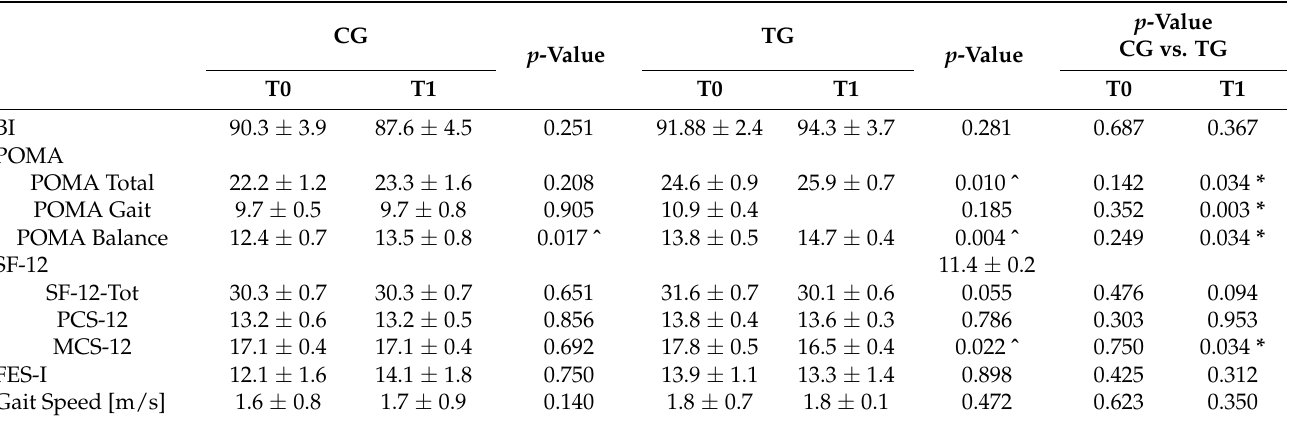
Table 2. Mean ± standard error of the mean of pre- and post-intervention scores on the BI, POMA (total, gait and balance), SF-12 (total, physical and mental component score), FES-I and gait speed. Pre-post and between groups comparisons are reported for each score ( p < 0.005). p -Value CG TG CG vs. p -Value p -Value